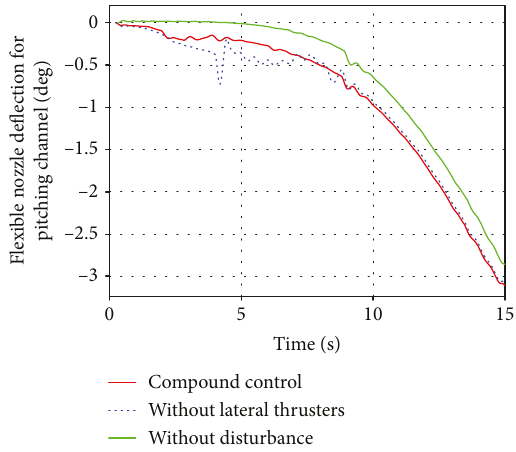
Figure 5: Variation of nozzle de fl ection for pitching channel in the initial stage of